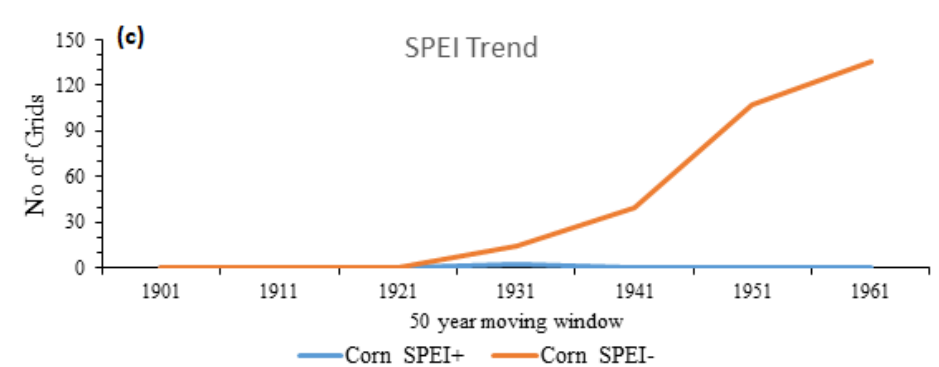
Figure 11 . The number of grid points at which significant changes in ( a ) precipitation, ( b ) mean temperature, and ( c ) SPEI during corn-growing season for different 50-year windows over 1901–2010.